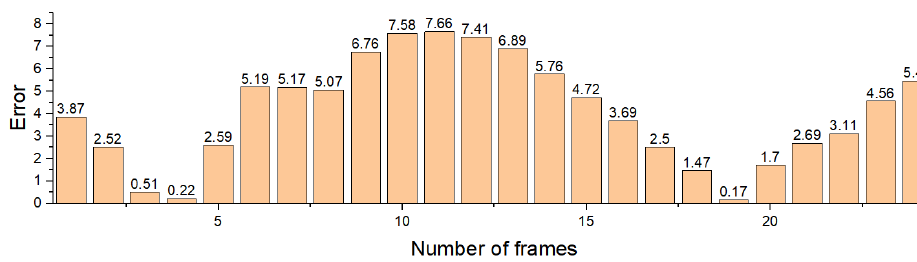
Figure 17. Distribution of error